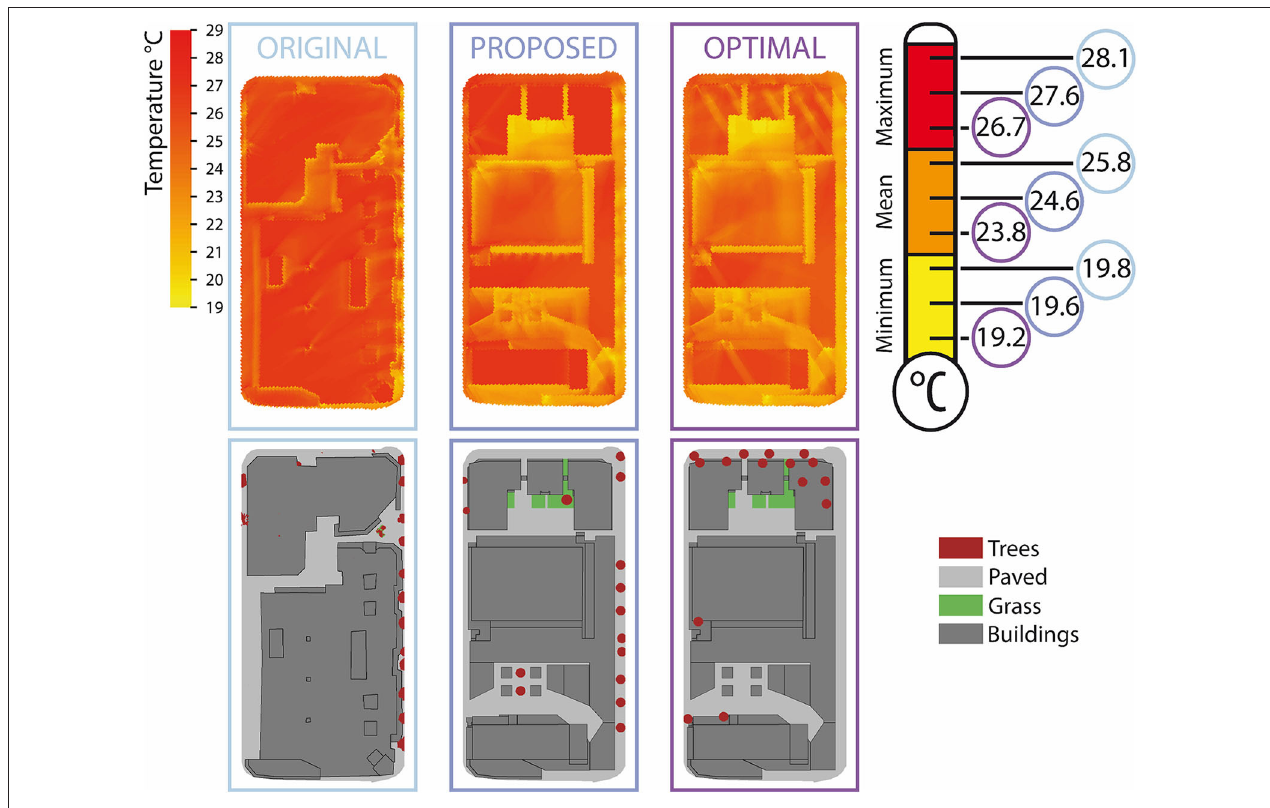
FIGURE 4 | Average annual temperature using the original urban footprint, proposed redevelopment plans, and proposed plans with optimal tree placement. Also indicated are the average annual minimum, mean, and maximum mean radiant temperature with color-coded circles for each urban footprint scenario. The proposed redevelopment constitutes increased building height and variation across the site enlarging shading potential, reducing site mean radiant temperature compared to the original urban